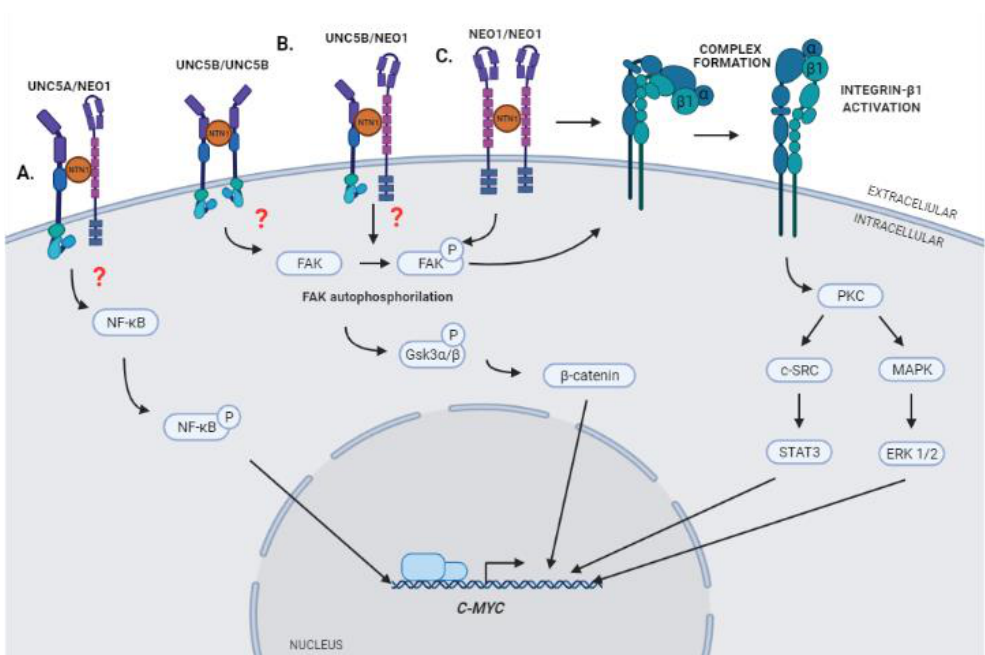
Figure 3. Schematic cartoon summarizing hypothetical models of Netrin-1 signaling that could promote expression of C-MYC . ( A ) Interaction of Netrin-1 with its receptor UNC5A may trigger the phosphorylation of NF-κB and the activation of the expression of C-MYC [10]. ( B ) Interaction of Netrin-1 with its receptors NEO-1 and UNC5B could promote the phosphorylation of Gsk3α/β and the stabilization of β-catenin, which in turn could trigger the expression of C-MYC [84]. ( C ) Interaction of Netrin-1 with its receptor NEO-1 could promote the activation of an Integrin heterodimer, formed by α and β 1 subunits, and trigger the expression of C-MYC through regulation of the MAPK/SRC axis. STAT3 and ERK 1/2 may promote the induction of C-MYC expression by acting as transcription factors in the promoting region of the gene [80].